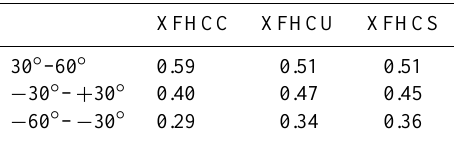
Table 7. AMS scores for precipitation for the northern and southern mid-latitudes and the